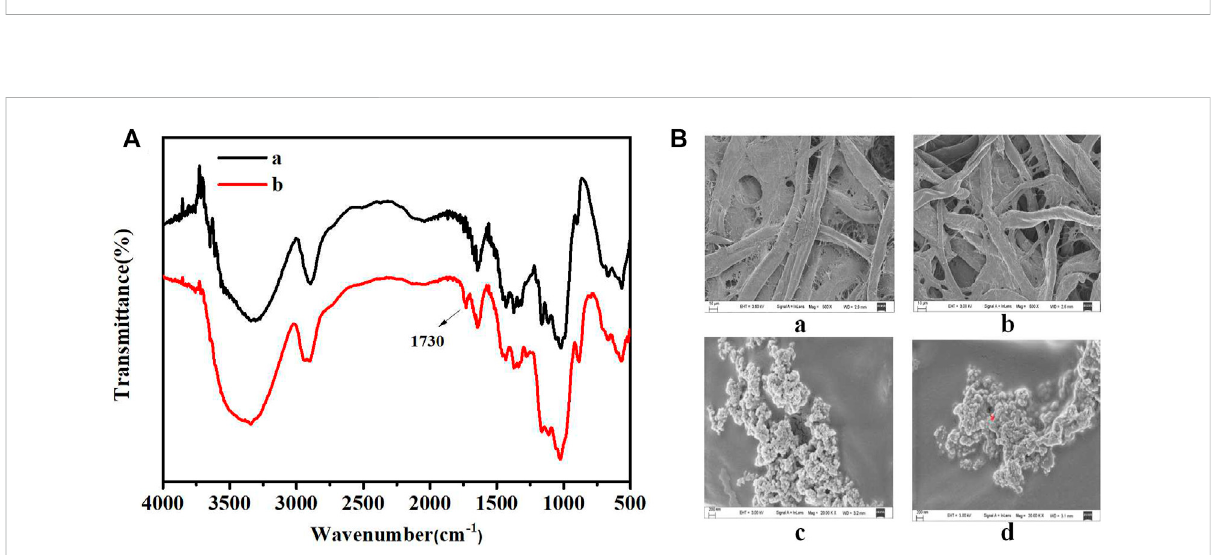
Supplementary Figure S2, the Zeta potential of UCNPs after being modi fi ed with positively charged PEI was signi fi cantly increased. These results revealed that the PEI containing amino groups had been successfully assembled onto the surface of